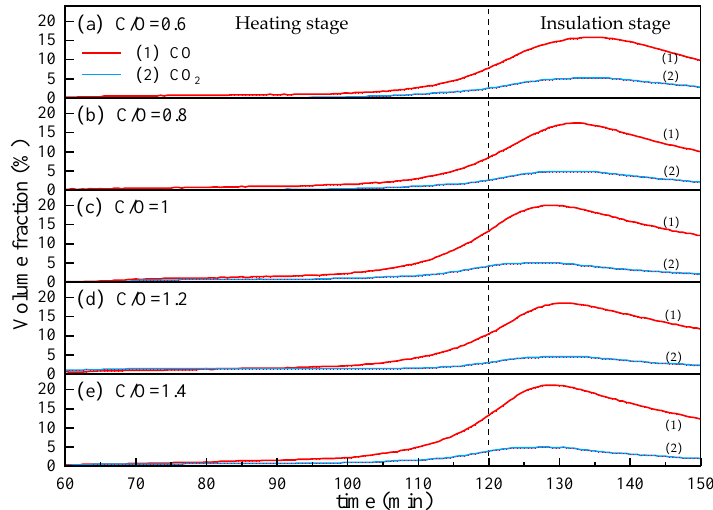
Figure 11. The influence of coal ratio on the CO and CO 2 contents in the off-gas.